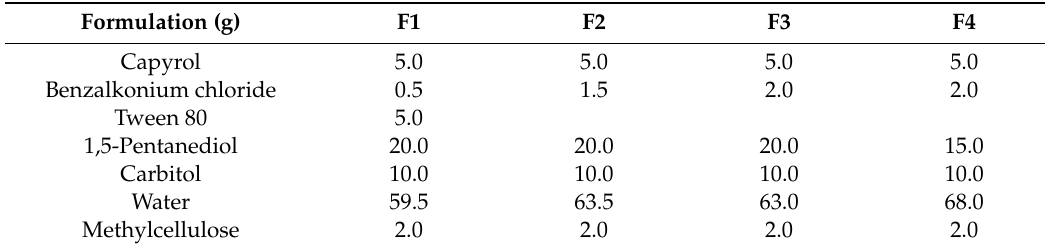
Table 1. Composition of